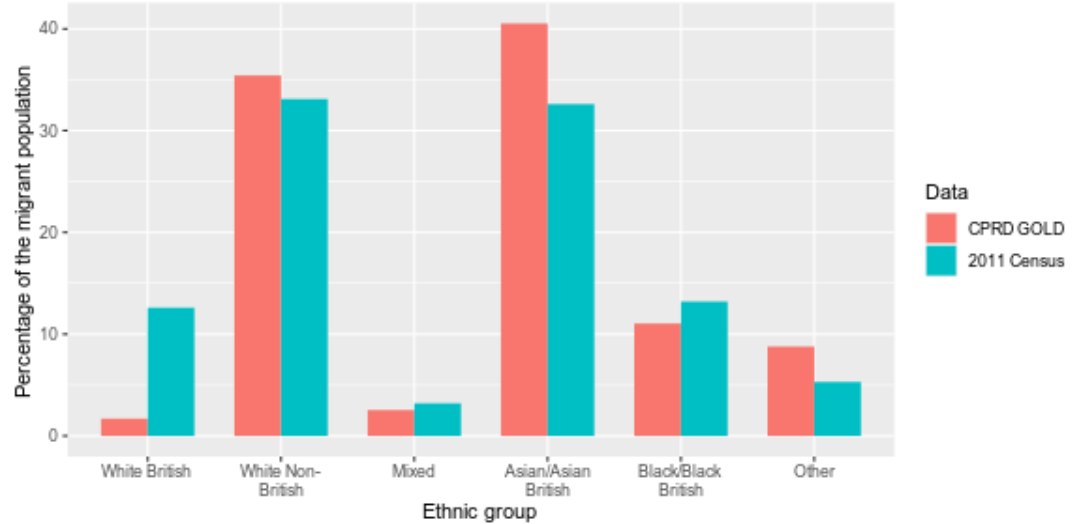
Figure 6. Percentage of migrants in CPRD (2011) and 2011 census by 6 higher-level ethnic